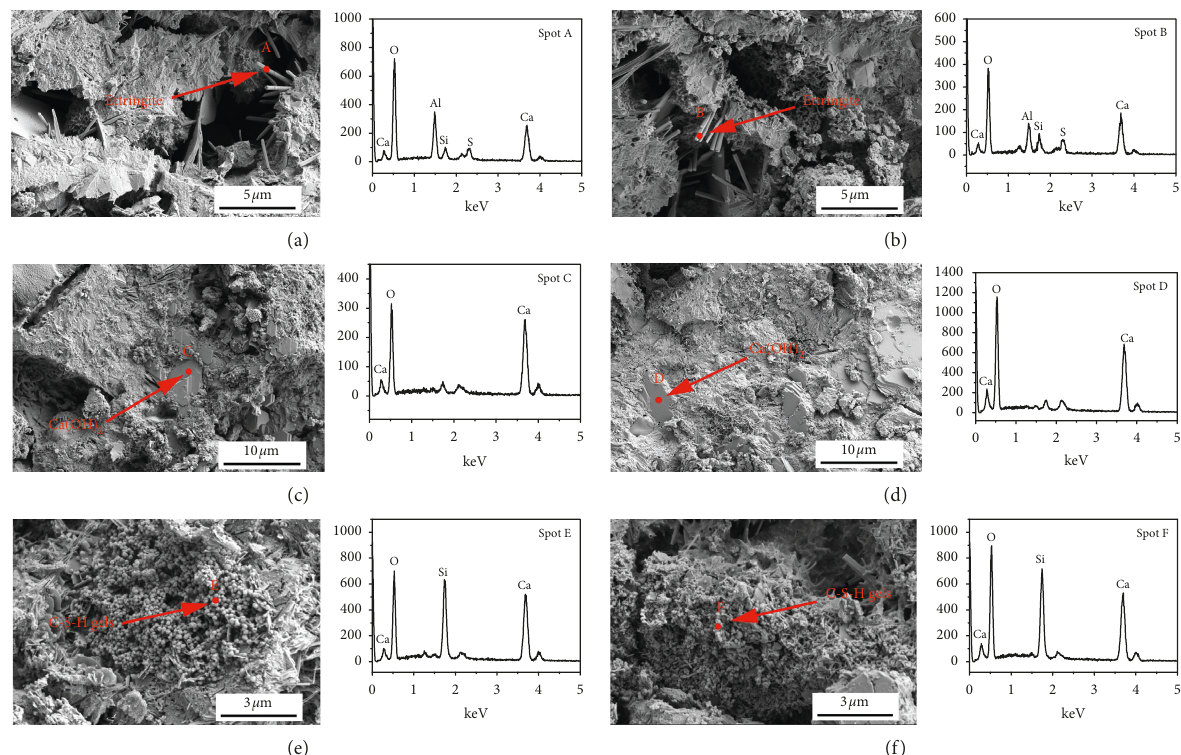
Figure 9: SEM images and EDS analysis results for C-SS paste ((a), (c), and (e)) and C-GTs paste ((b), (d), and (f)) at age of